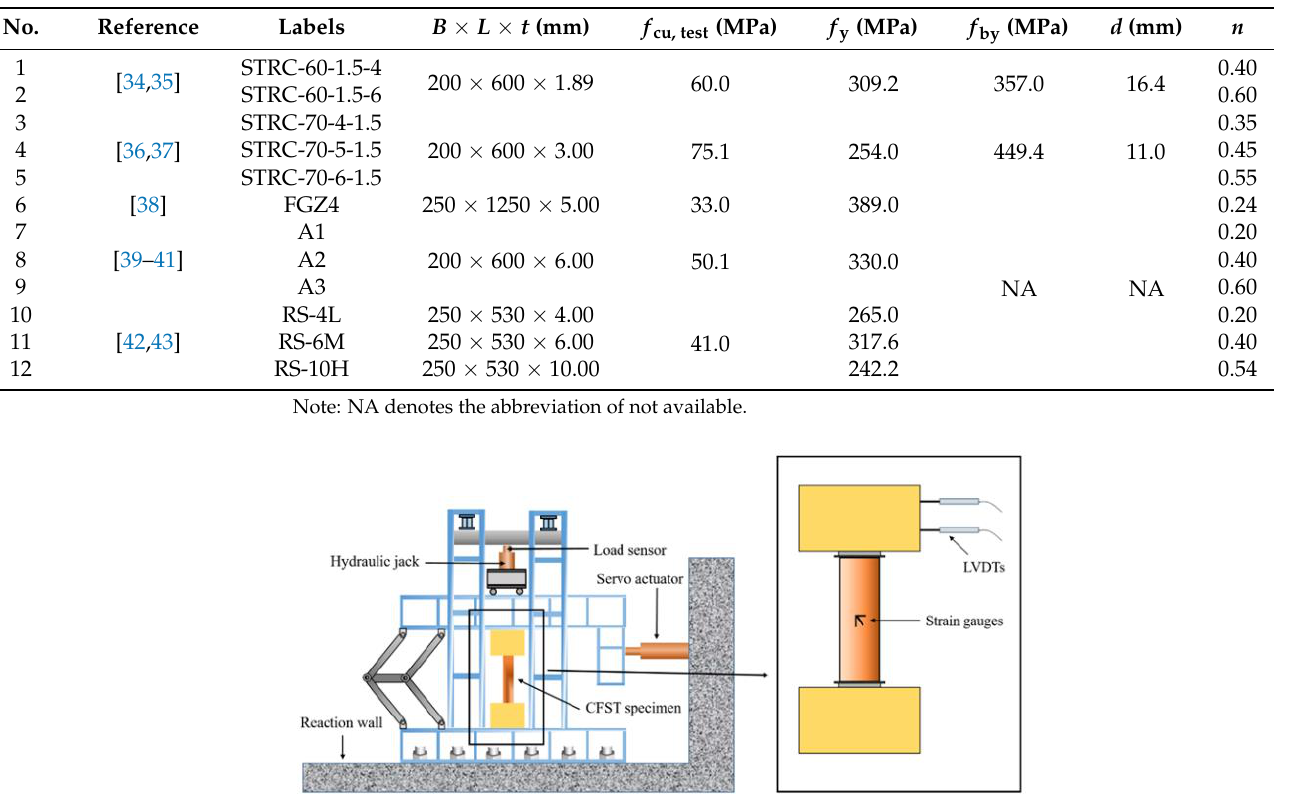
Table 1. Table 1. Specifications of the tested CFST columns in Refs. [34–43].